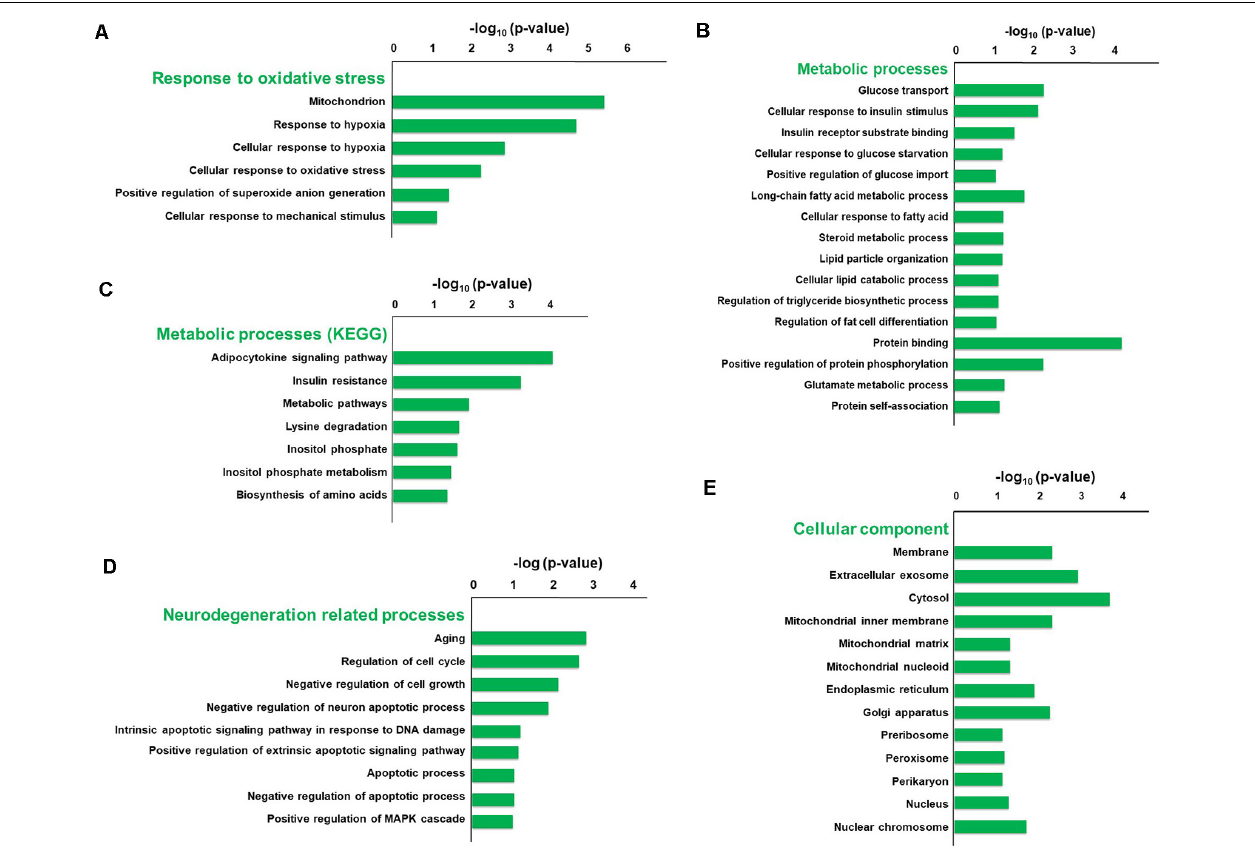
FIGURE 3 | Gene Ontology (GO) and KEGG enrichment analysis of differentially expressed genes using the DAVID database. The typical terms were displayed and ranked according to the value of − log 10 ( p -value), including six GO terms related to oxidative stress (A) , 28 GO terms and seven KEGG terms related to metabolism (B,C) , 12 GO terms related to aging and neurodegeneration (D) , and 20 GO terms of cellular component (E)